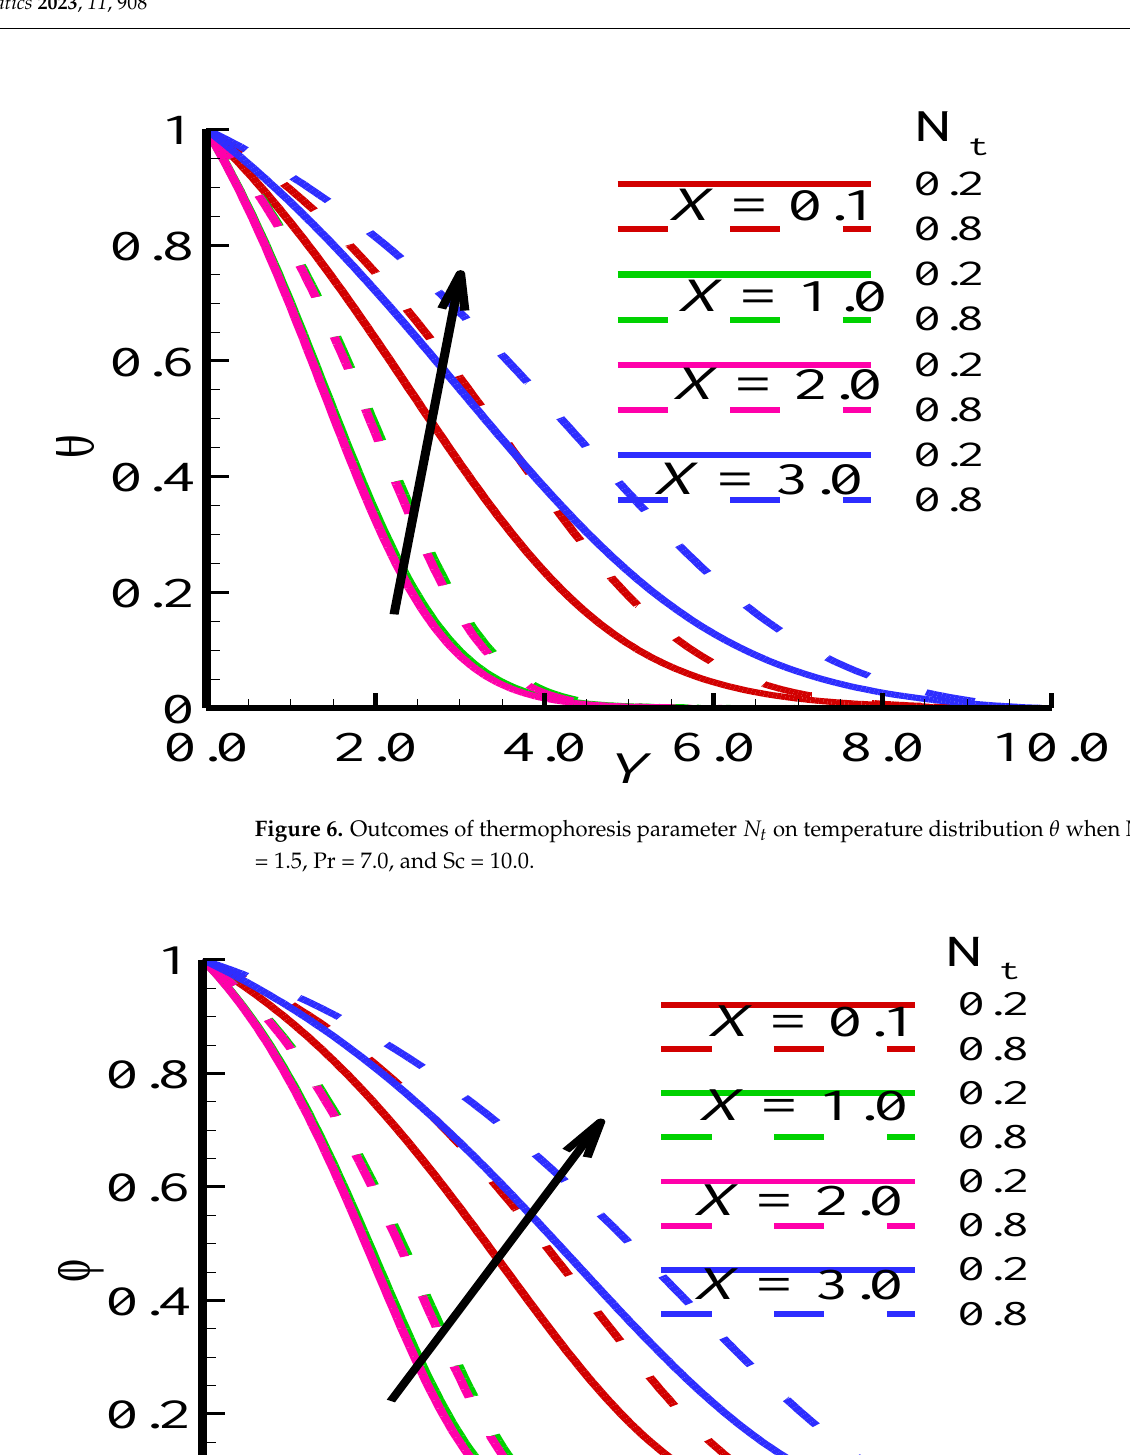
Figure 5. Outcomes of thermophoresis parameter 𝑁 𝑡 on velocity distribution 𝑈 when N = 0.5, Nb = 1.5, Pr = 7.0, and Sc = 10.0.